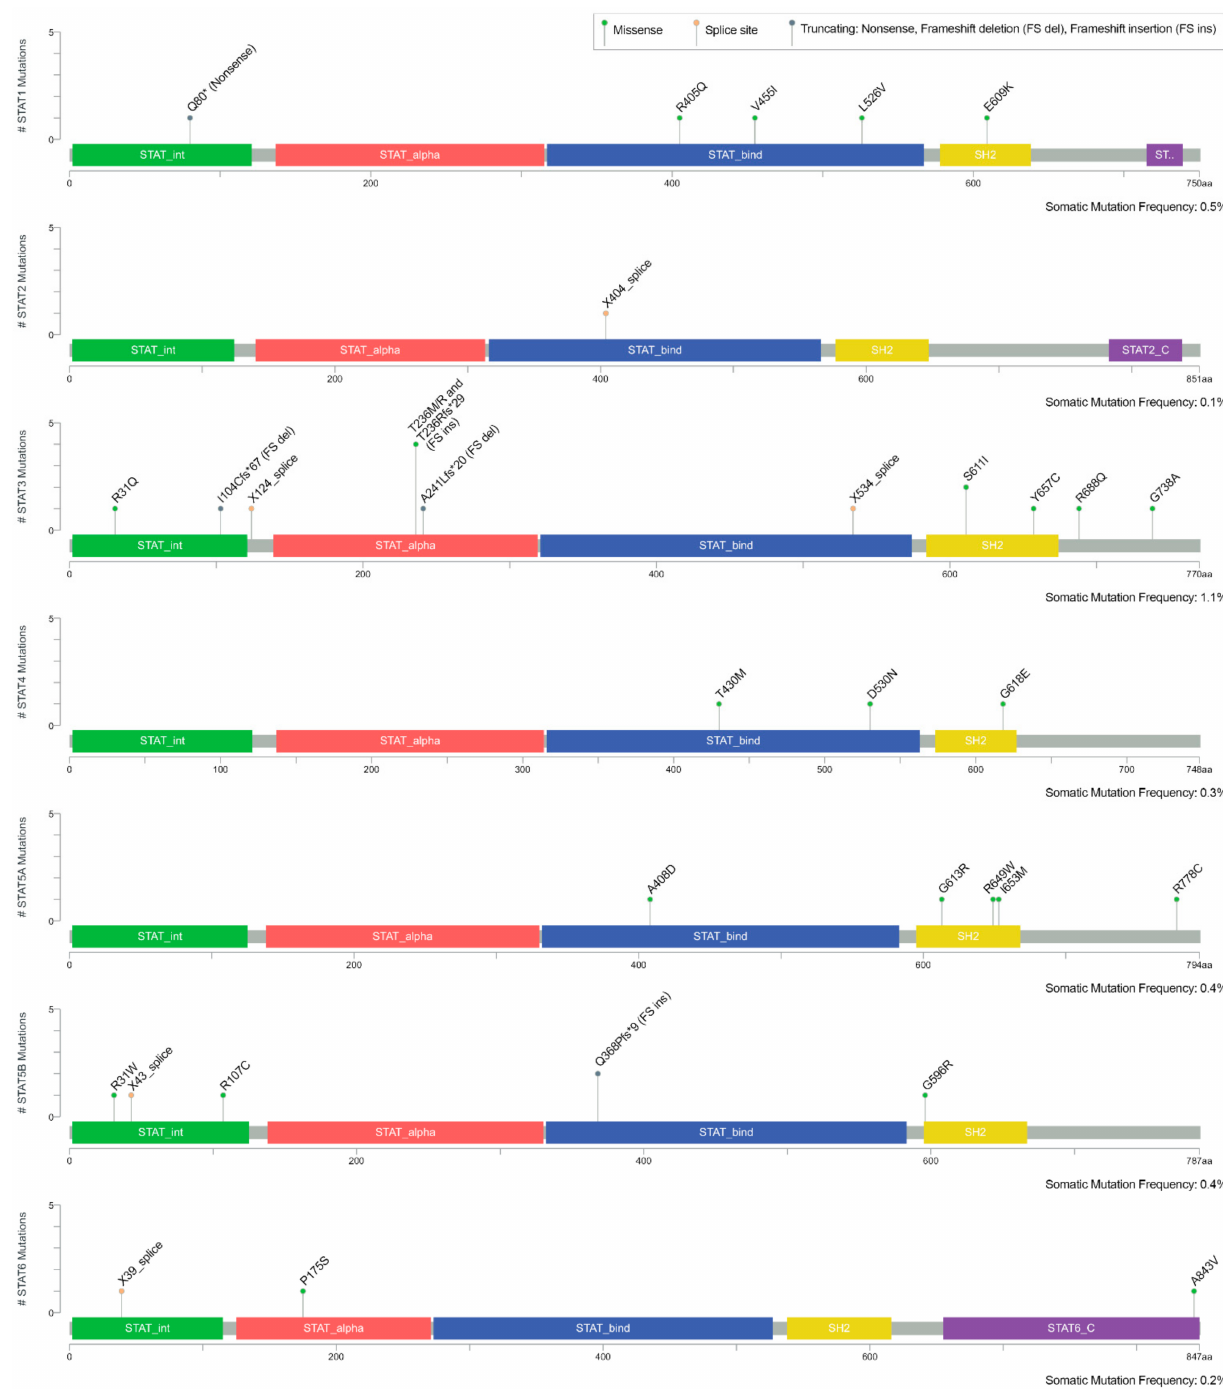
Figure 3. Mutations in STAT proteins in metastatic PCa [76,77]: This combined study contains 1562 metastatic sam- ples from 1451 PCa patients in 16 studies: Metastatic Prostate Adenocarcinoma (MCTP, Nature 2012) [78], Metastatic Prostate Adenocarcinoma (SU2C/PCF Dream Team, PNAS 2019) [79], Metastatic Prostate Cancer (SU2C/PCF Dream Team, Cell 2015) [80], Metastatic castration-sensitive prostate cancer (MSK, Clin Cancer Res 2020) [81], Prostate Adenocarcinoma (Broad/Cornell, Cell 2013) [82], Prostate Adenocarcinoma (Broad/Cornell, Nat Genet 2012) [83], Prostate Adenocarcinoma (CPC-GENE, Nature 2017) [84], Prostate Adenocarcinoma (Fred Hutchinson CRC, Nat Med 2016) [85], Prostate Adenocar- cinoma (MSK, Eur Urol 2020) [86], Prostate Adenocarcinoma (MSKCC, Cancer Cell 2010) [87], Prostate Adenocarcinoma (MSKCC, PNAS 2014) [88], Prostate Adenocarcinoma (MSKCC/DFCI, Nature Genetics 2018) [89], Prostate Adenocarcinoma (SMMU, Eur Urol 2017) [90], Prostate Adenocarcinoma (TCGA, Cell 2015) [91], Prostate Adenocarcinoma (TCGA, PanCancer Atlas) [92–101], Prostate Cancer (MSKCC, JCO Precis Oncol 2017) [102], generated on 10 March